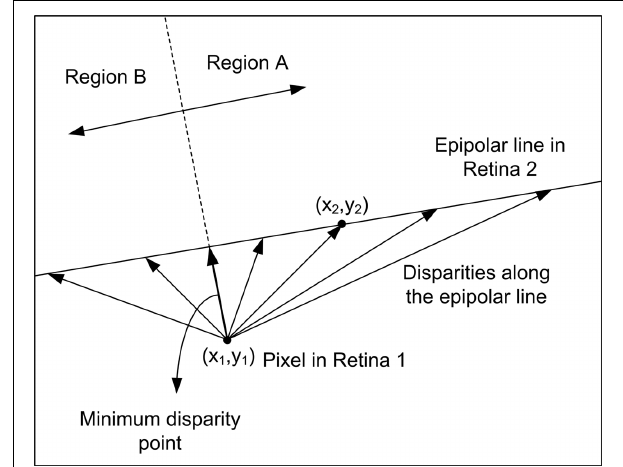
FIGURE 7 | Block diagram for a sample network with 3 × 3 convolutional blocks implemented on FPGA.